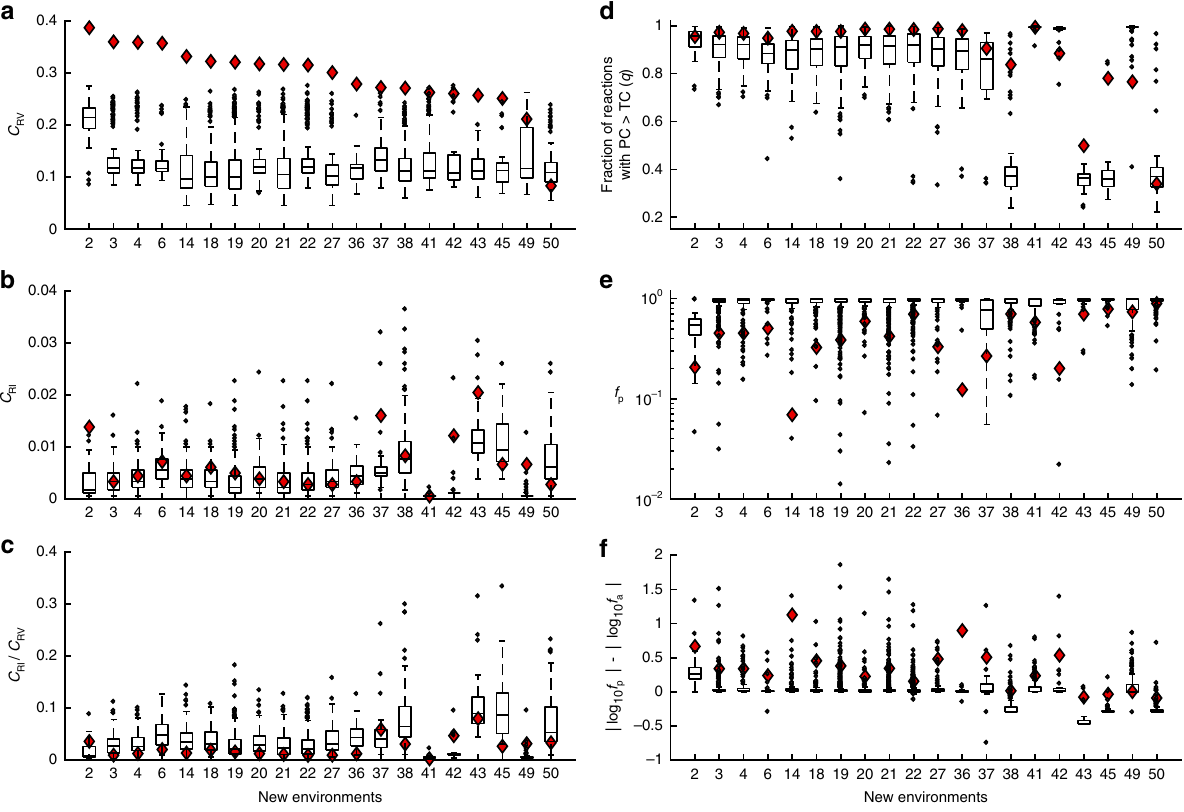
Fig. 4 Predominance of fl ux reversion in random metabolic networks. Fractions of reactions showing fl ux reversion ( C RV ) ( a ), fractions of reactions showing fl ux reinforcement ( C C C RI ) ( b ), RI / RV ratios ( c ), fraction of reactions showing PC networks from the glucose environment to each of the 20 new environments examined. For each new environment, values estimated from different random networks are shown by a box plot, with symbols explained in the legend to Fig. 2d. The corresponding values for the E. coli i AF1260 network are shown by red